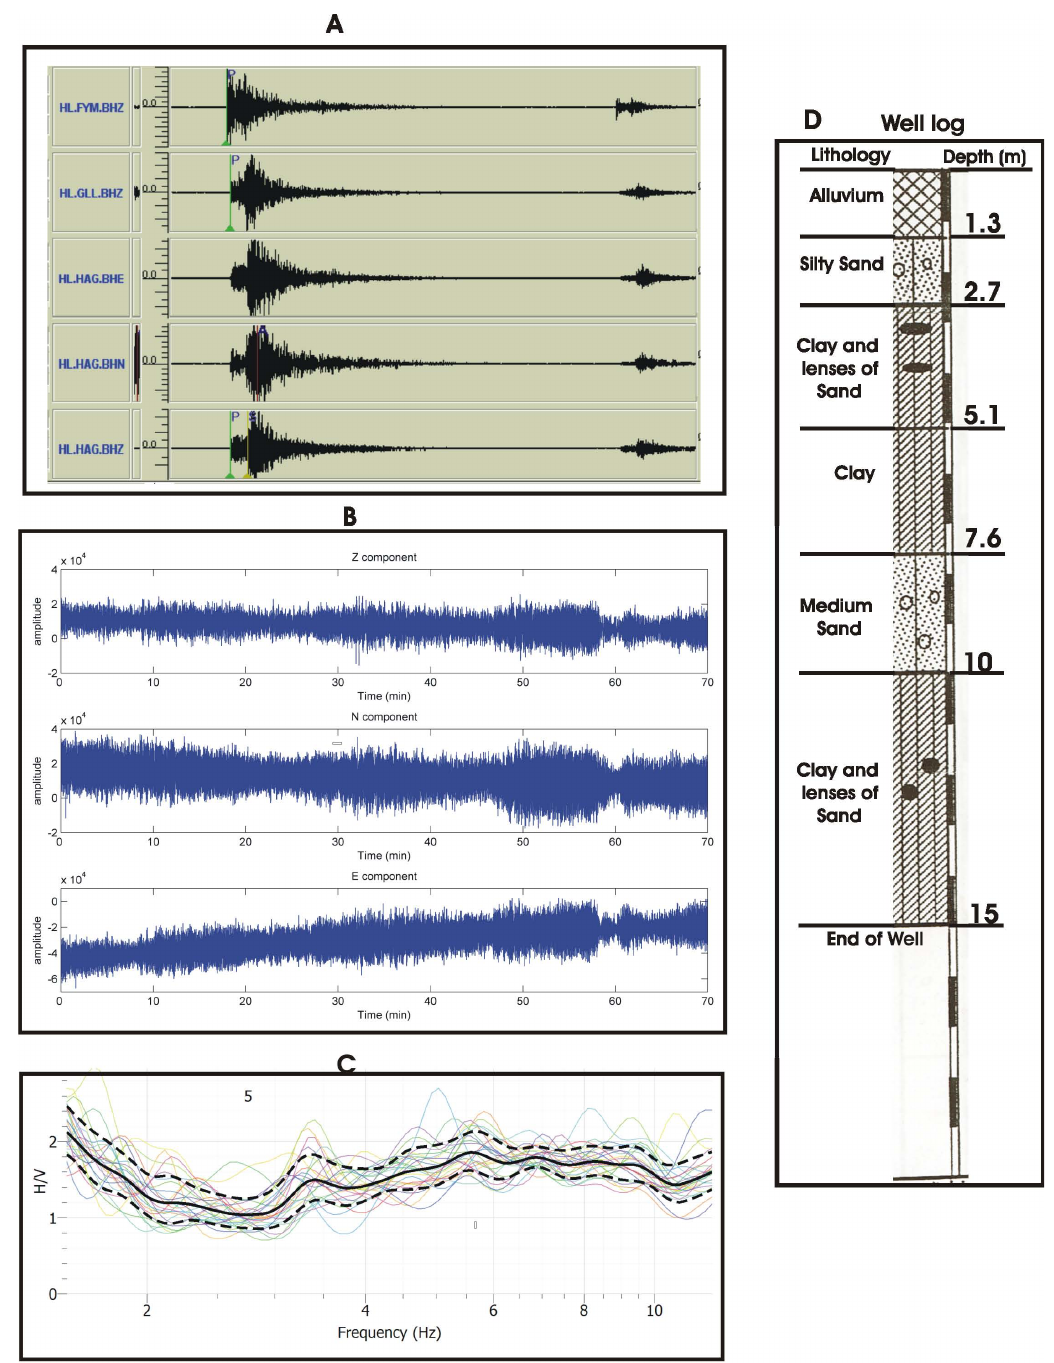
Fig. 5. Examples of digital and analog data used in the current study. Panel A is the digital waveform for the 24 August 2002 earthquake and its aftershock. Panel B is the digital waveforms of recorded background noise. Panel C is the H/V result of recorded background noise at site 13. Panel D represents the analog data of borehole at site